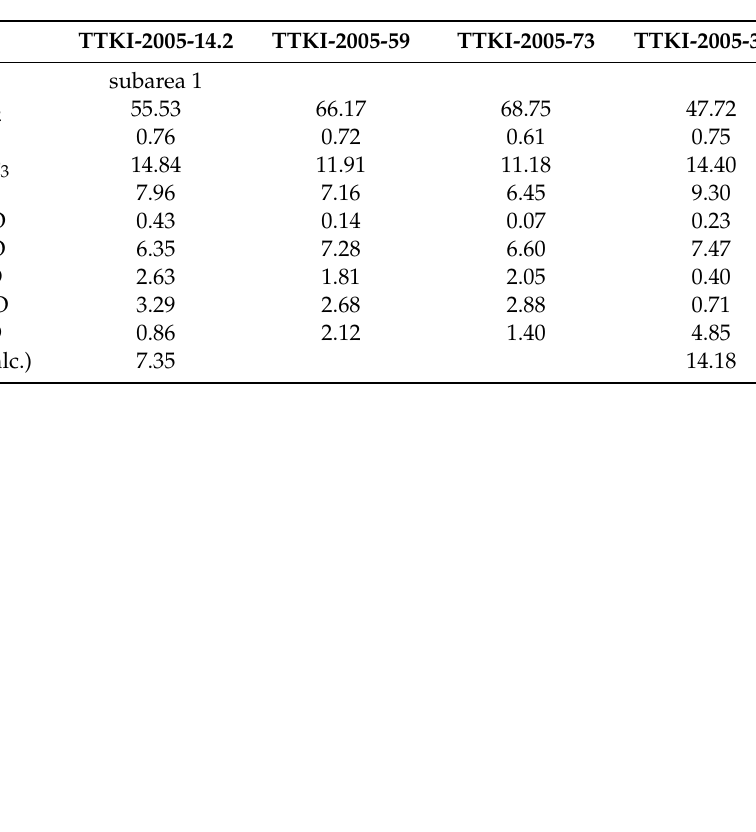
Table 1. Whole-rock compositions (mol. %) used for the construction of the pseudosections in Figure 13 and Supplementary Materials, Figure S8. TTKI-2005-14.2 and TTKI-2005-32.2 are calculated from the QEMSCAN modal analyses and mineral compositions, TTKI-2005-59 and TTKI-2005-73 are from XRF analyses. Subarea 1 refers to the area in the thin section presented in Figure 6 and Figure S4 in Supplementary